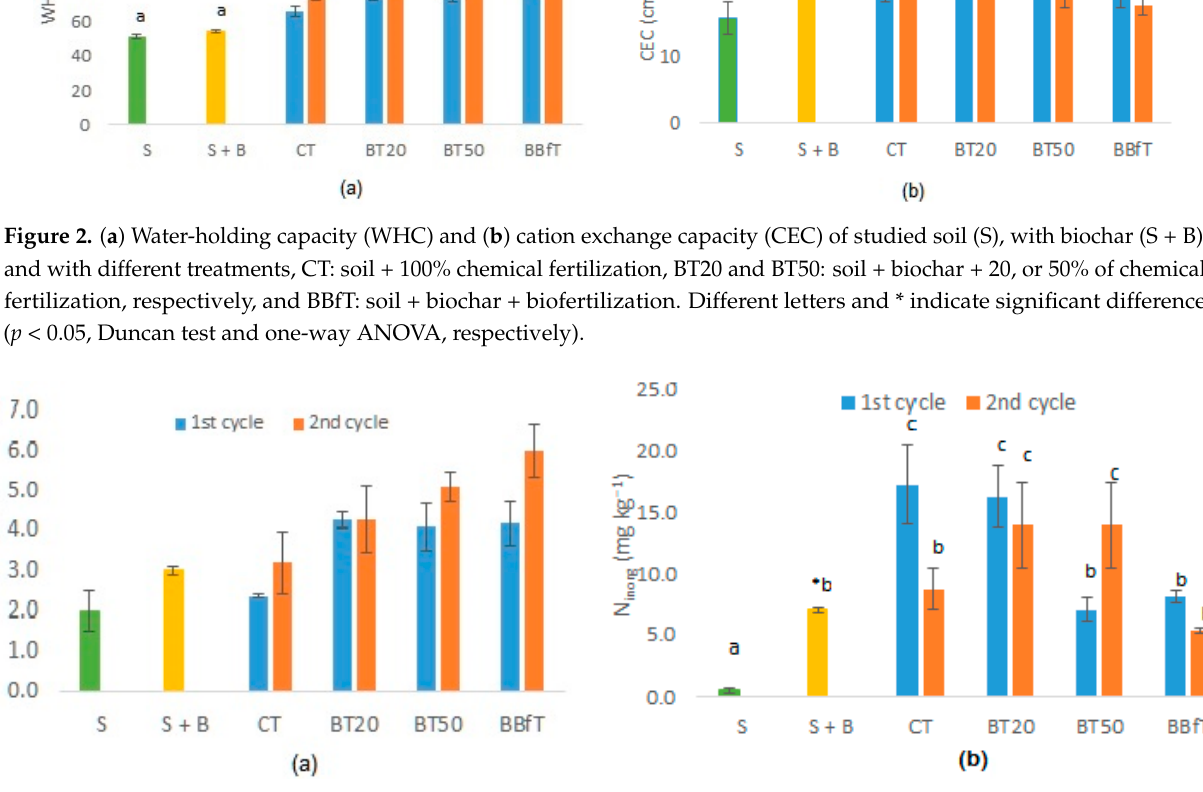
or biofertilizers, which could drastically alter their pH. For that, this study aimed to evaluate the Figure 4. Available phosphorus (P av ) in studied soil (S), with biochar (S + B), and with different treatments: CT: soil + 100% of chemical fertilization, BT20 and BT50: soil + biochar +, 20, or 50% of chemical fertilization, respectively, and BBfT: soil + biochar + biofertilization. Different letters indi- cate significant difference ( p < 0.05, Duncan test and one-way ANOVA, respectively). Other positive changes in the soil fertility were significant increases ( p < 0.05) in the content of OM from very low (2%) to low content (3%); CEC improved from medium (16 cmol+·kg − 1 ) to high content (33 cmol+·kg − 1 ); N inorg showed the greatest increase (from 0.5 to 7 mg·kg − 1 ), although the content is still very low. Likewise, P av raised from 24 to 35 effectiveness of a low biochar and biofertilizer addition to improve soil characteristics and the use of nutrients to reduce the doses of chemical fertilizer. For that, we measured the initial effect of biochar addition on the soil characteristics. Then, to evaluate the changes produced by biochar and biofertilizer on cultivated soil, we carried out a greenhouse experiment with Physalis ixocarpa for two crop cycles. We also studied the nutrient use efficiency, comparing chemical fertilization at 100% (without biochar) against 50% and 20% with biochar on crop yield, plant height, fruit weight, and root length. Finally, we compared the combination of biochar and biofertilizer with the treat- ments mentioned earlier. The results showed that after adding 0.2% of bamboo biochar, bulk density (BD) decreased while CEC, as well as OM, P av , Fe, and Cu contents, increased in the soil. The com- bination of biochar and biofertilizer improved WHC, P av , and OM comparing to the soil added with biochar. We found that the bamboo biochar and nopal-based fertilizer are suitable improvers for the studied soil. Keywords: soil conditioner; degraded soils; bioproducts; Physalis ixocarpa ; Opuntia ; desertification; bamboo biochar; nopal biofertilizer; drylands; low buffering capacity